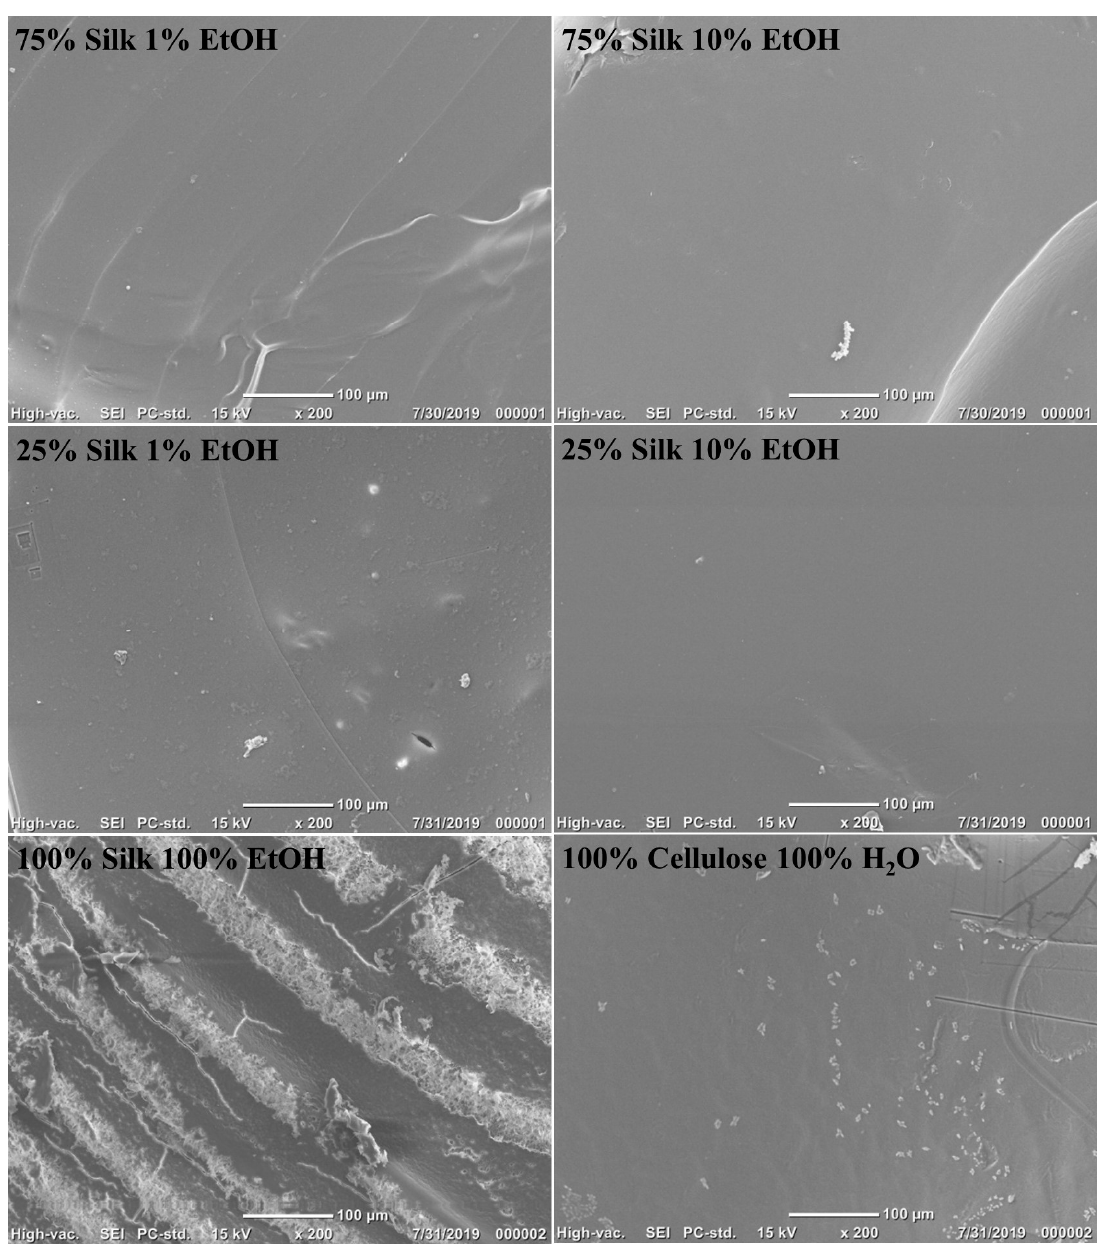
Figure 2. Scanning electron microscopy (SEM) images of 100% regenerated films and varied biopolymer ratio samples using various coagulation agents.